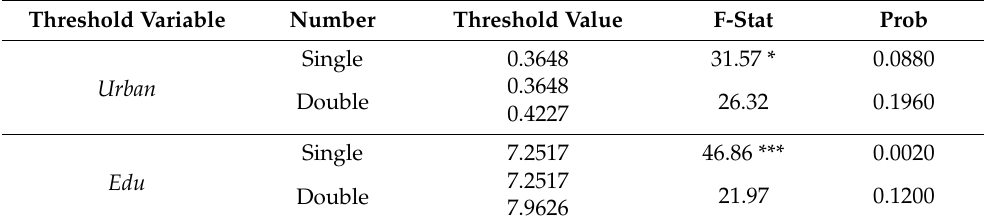
Table 8. Threshold value estimation results.